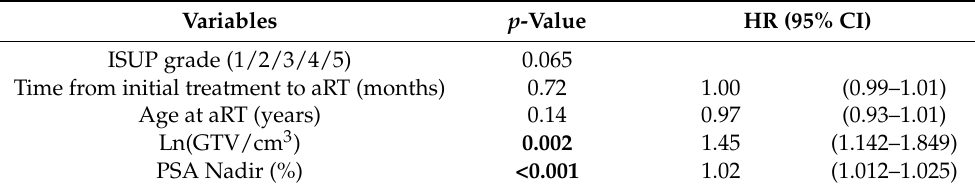
Table 5. Multivariate Cox regression analysis for time to first failure after